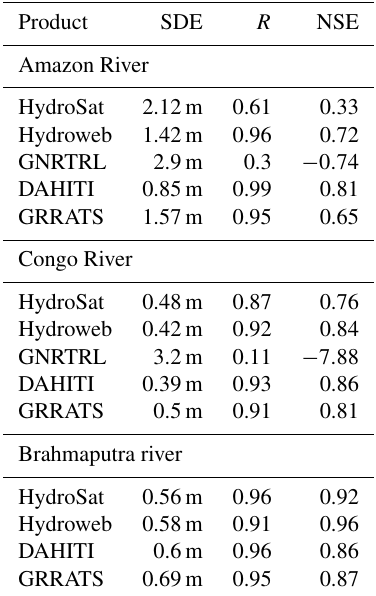
Table 4. Multiproduct fit statistics from Fig.